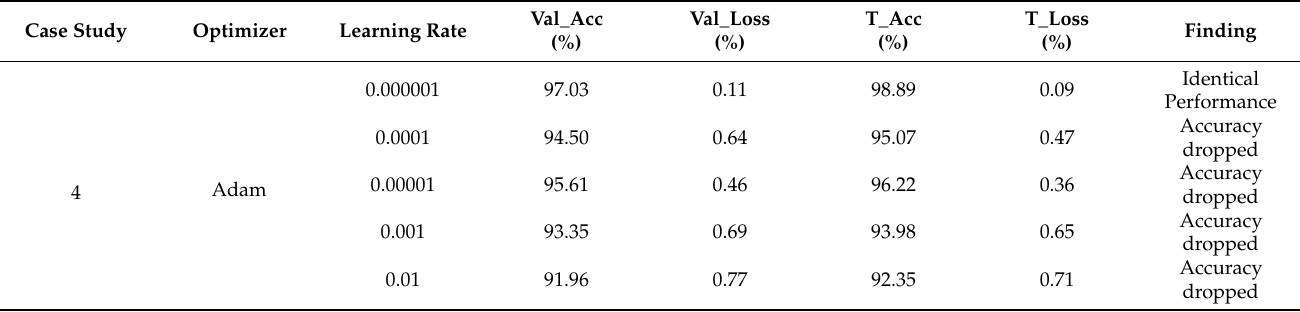
Table 9. Changing Optimizer and Learning rate to evaluate the ablation